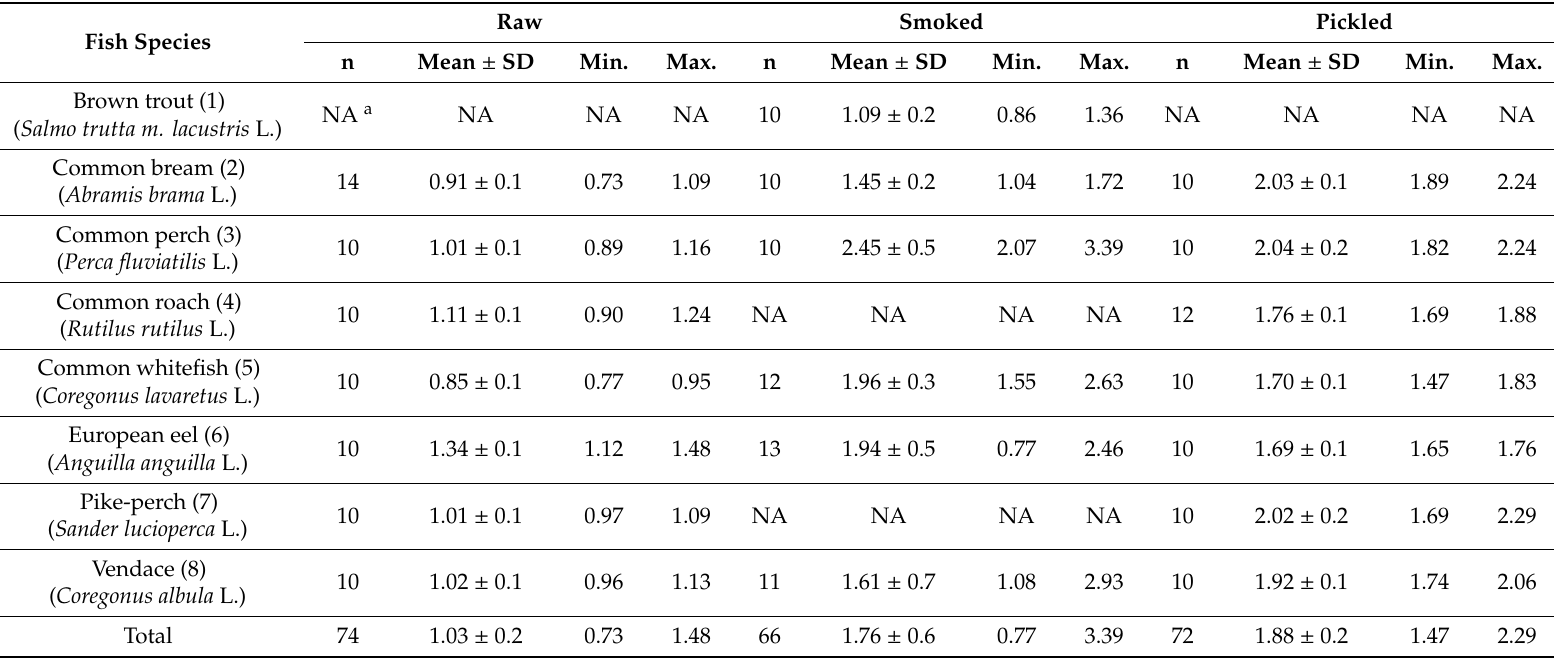
Table 3. Salt content in raw, smoked and pickled fish product samples (g / 100 g). Raw Smoked Pickled Fish Species n Mean ± SD Min. Max. n Mean ± SD Min. Max. n Mean ± SD Min. Max. NA a NA NA